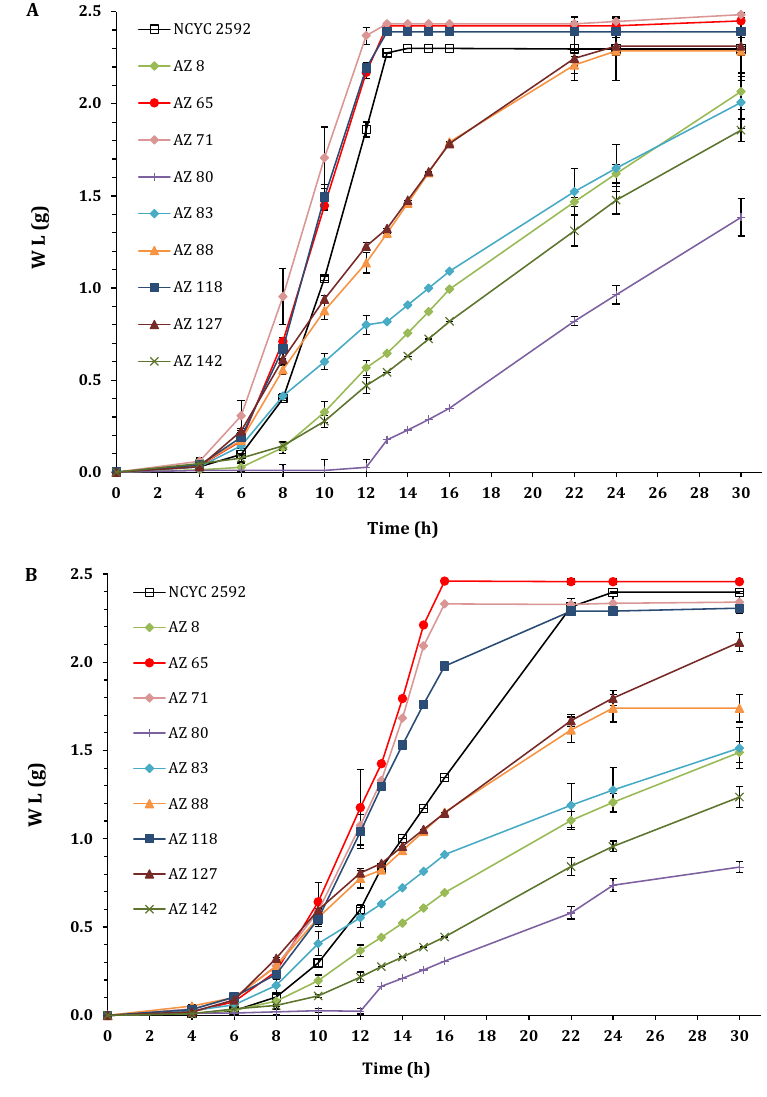
Figure 1. Screening for ethanol producing marine yeast using ( A ) SW-YPD medium and ( B ) ROW-YPD medium. AZ8 to AZ142 are nine marine yeast strains under investigation for bioethanol production NCYC2592 is a terrestrial S . cerevisiae strain used as a reference for comparison. Weight loss - as a result of CO 2 release from the MFVs - was measured during the fermentation at different time intervals to assess the fermentation performance of each yeast strain. The experimental error bars represent the standard deviation of the three